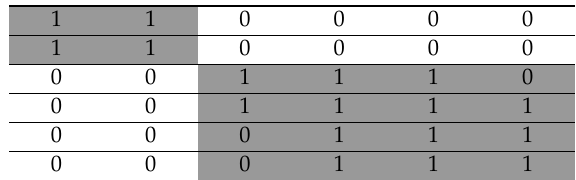
Table 2. Compressed matrix ( UPA compressed ) 6 × 6